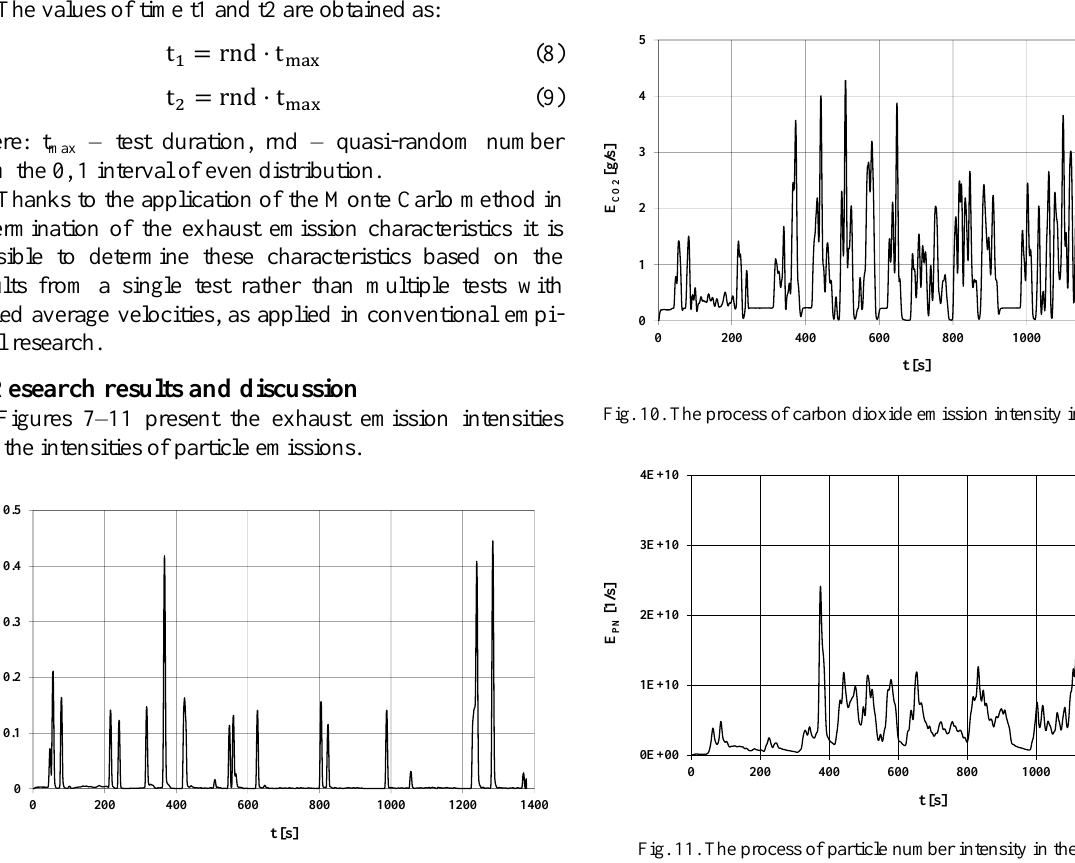
Fig. 7. The process of carbon monoxide emission intensity in the Malta test